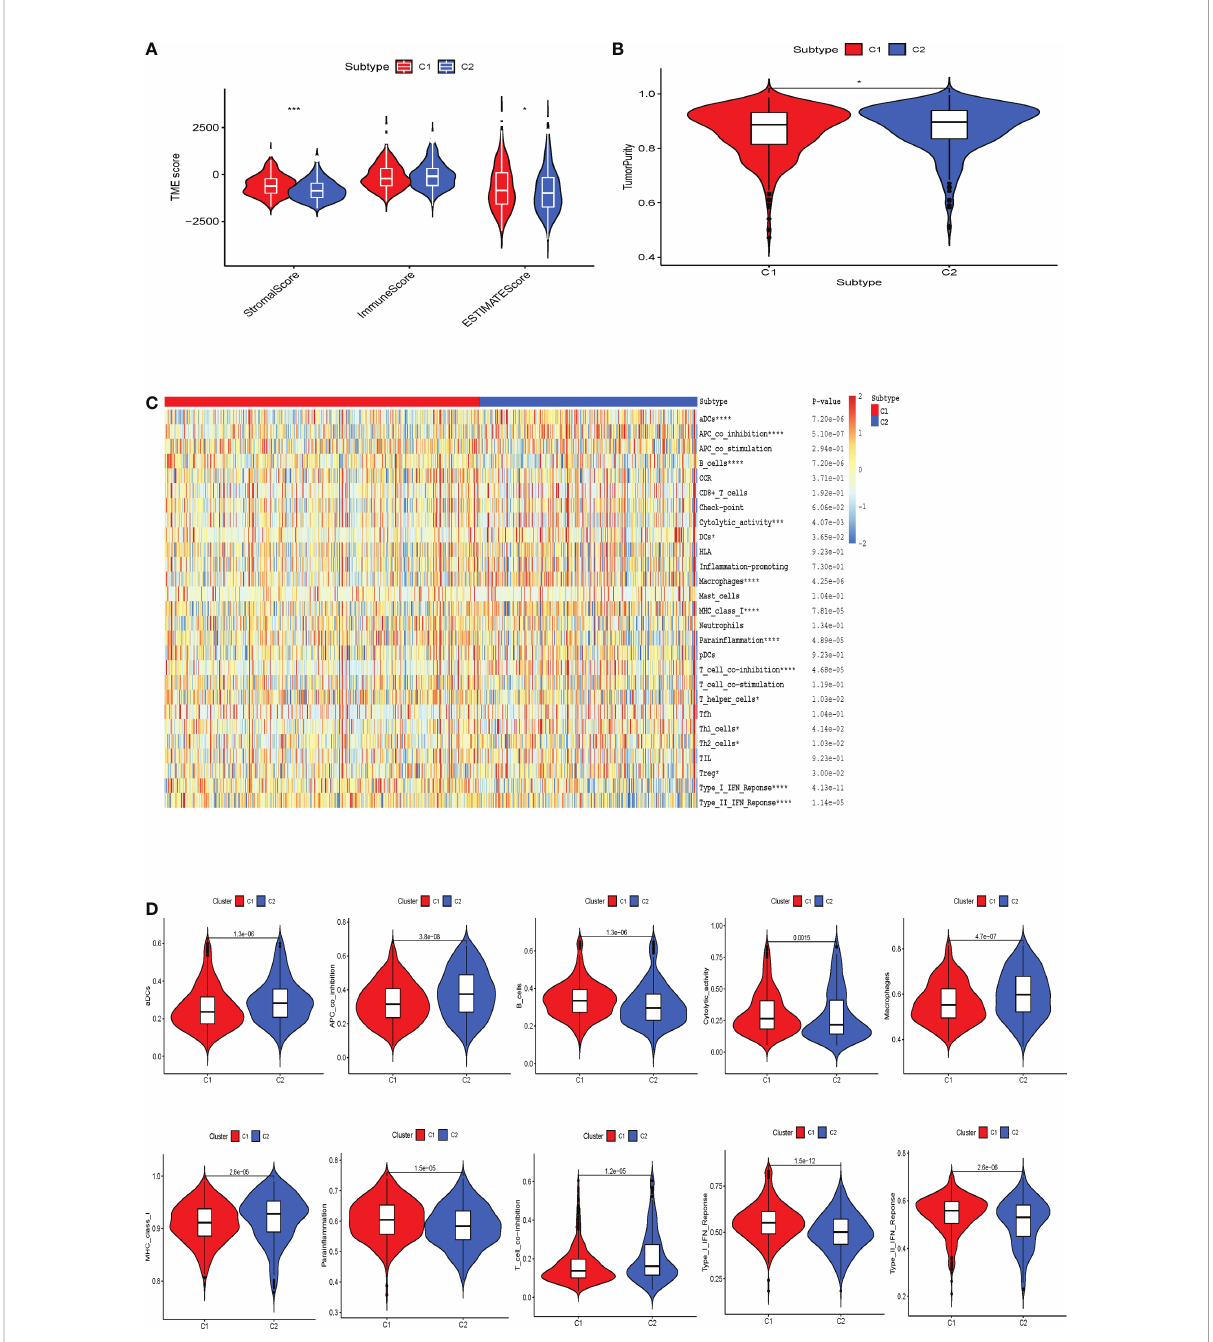
FIGURE 3 The correlation between the tumor microenvironment features and the CS patterns. (A) Quantitative comparison of estimated, immune and stromal scores of the two phenotypes. (B) Quantitative comparison of the tumor purity of the two phenotypes. (C) Visualization of the two CS phenotypes by heat map to obtain the enrichment levels of 29 immune-related cells as assessed by the ssGSEA algorithm and quantitative analysis. *p < 0.05; ***p < 0.001; ****p < 0.0001. (D) Box plots exhibited the degree of difference in immune composition between the two